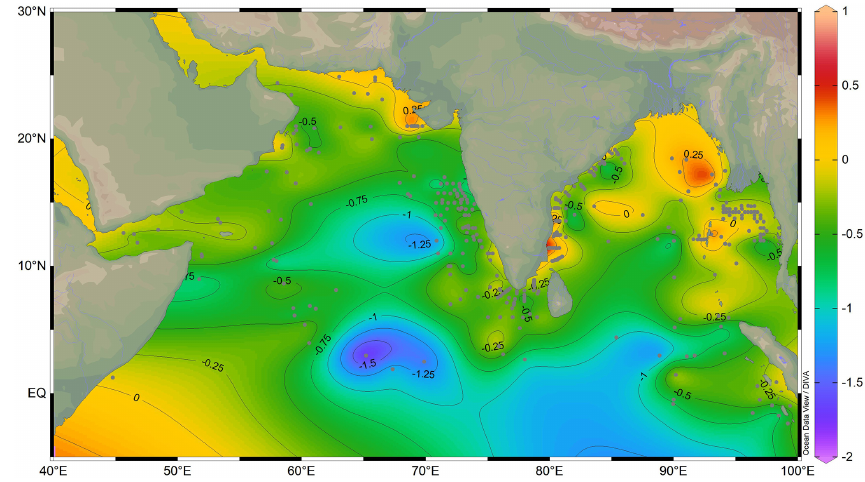
Figure 11. The difference in the expected δ 18 O calcite and observed δ 18 O ruber ( δ 18 O residual ) in the surface sediments of the northern Indian Ocean. The grey-filled squares are the sample locations. The thin blue lines are the major rivers draining in the northern Indian Ocean. The thin black lines mark the contours at 0.25‰ intervals. The map was prepared by using Ocean Data View software (Schlitzer, 2018).